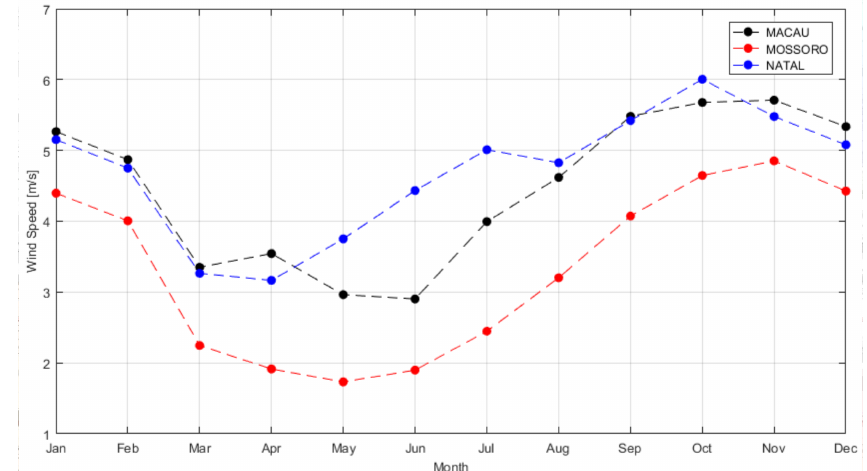
Figure 5. Wind speed seasonality.